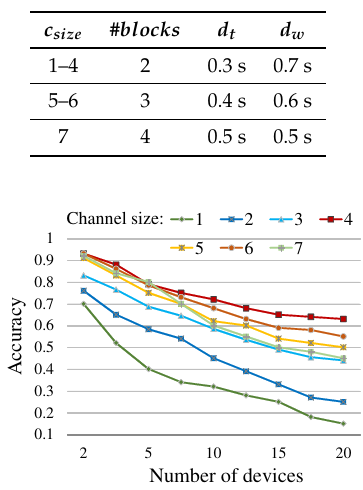
Figure 8. Accuracy by channel size: the graph shows the accuracy (on y -axis) that is the rate of successfully resolving a single responder in a group within the time constraint, with respect to the number of devices in a group (on x -axis). The simulation experiment was performed 100 times for each pair of channel size and group